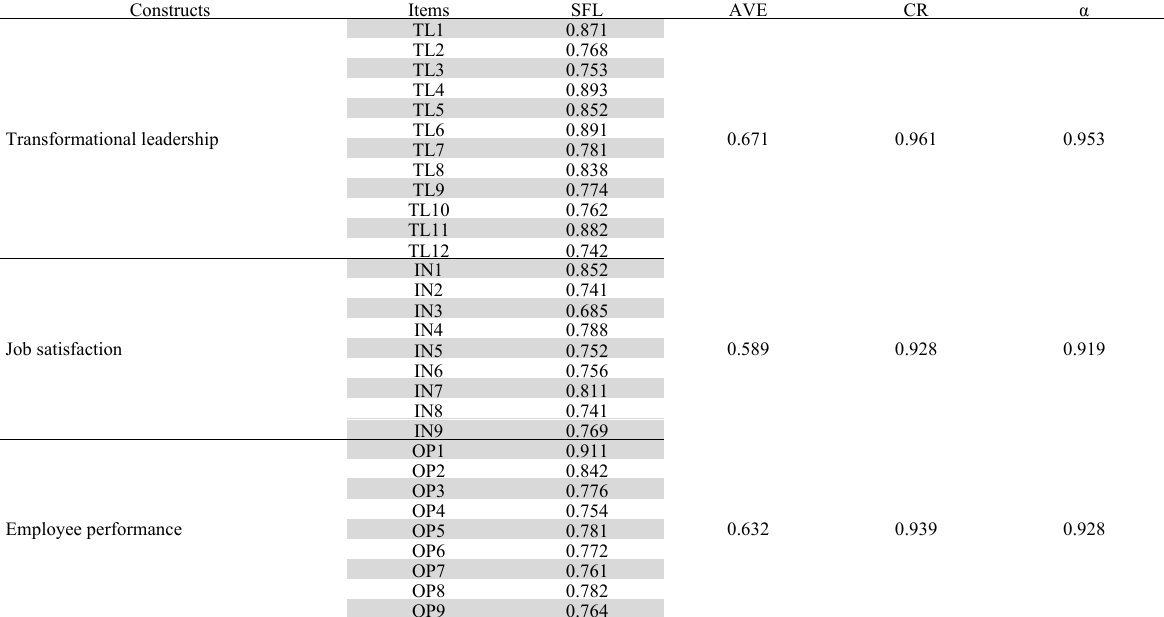
Results of exploratory factor analysis Constructs